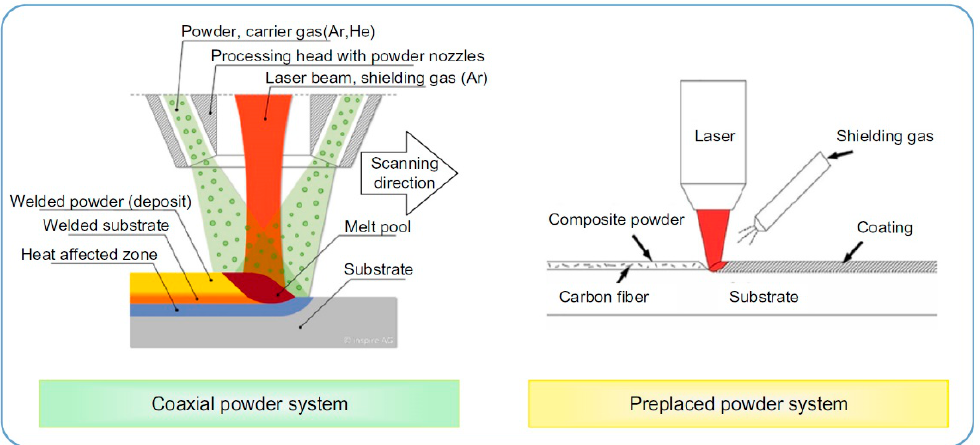
Figure 1. Scheme showing the laser cladding systems for coaxial ( left ) and preplaced ( right ) powder cases. Reprinted with permission from Ref. [1]. Copyright 2021 Elsevier.